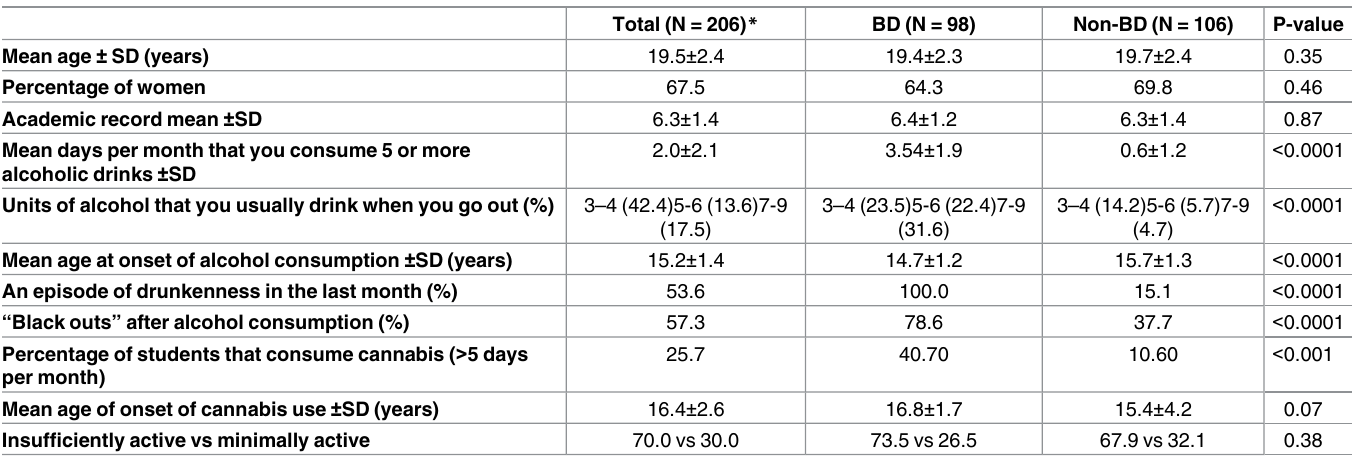
Table 1. Sociodemographic characteristics.